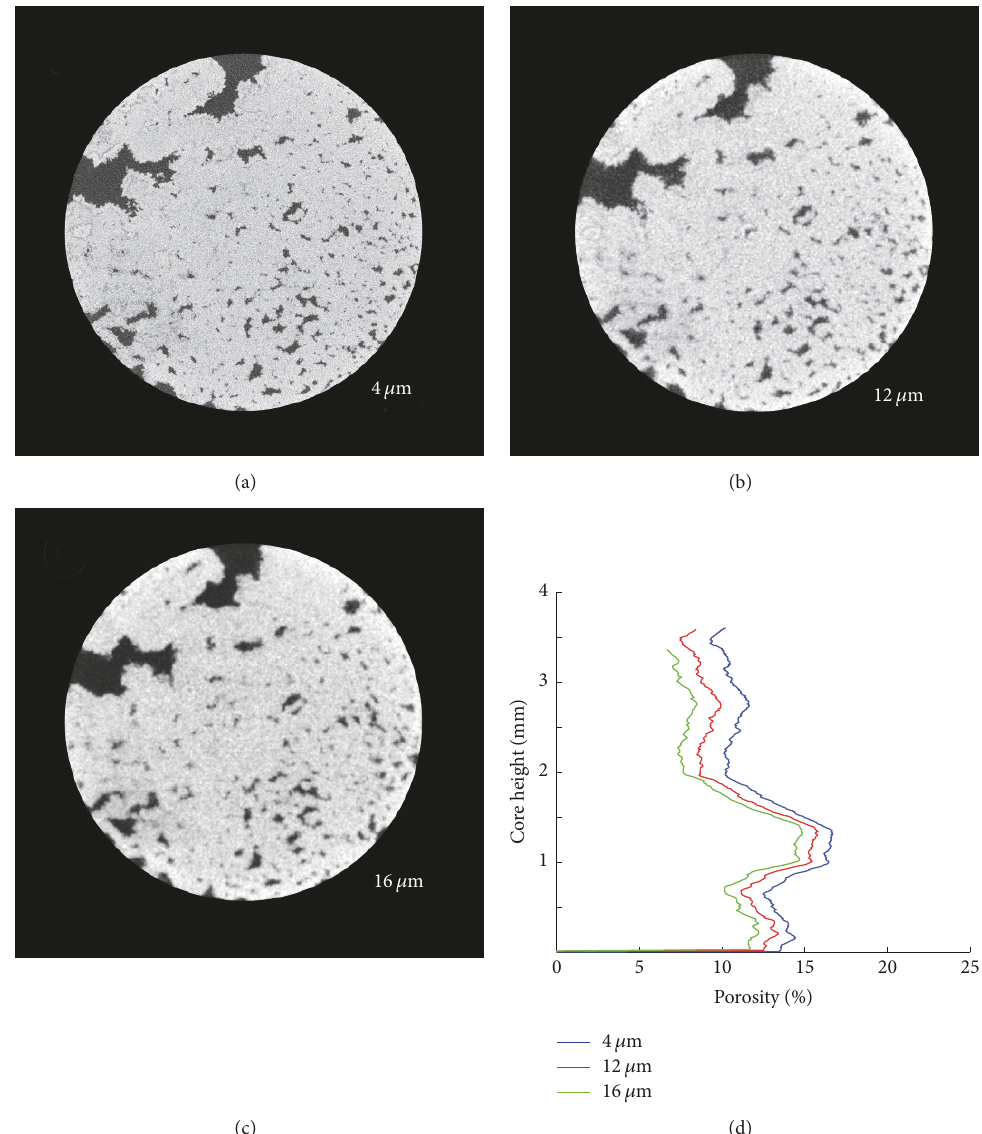
Figure 10: Influence of the resolution on the measured porosity network in a miniplug with a diameter of 7mm. Comparison of the same slice scanned at (a) 4 𝜇 m, (b) 12 𝜇 m, and (c) 16 𝜇 m resolution. (d) Comparison of the calculated porosity in function of the plug